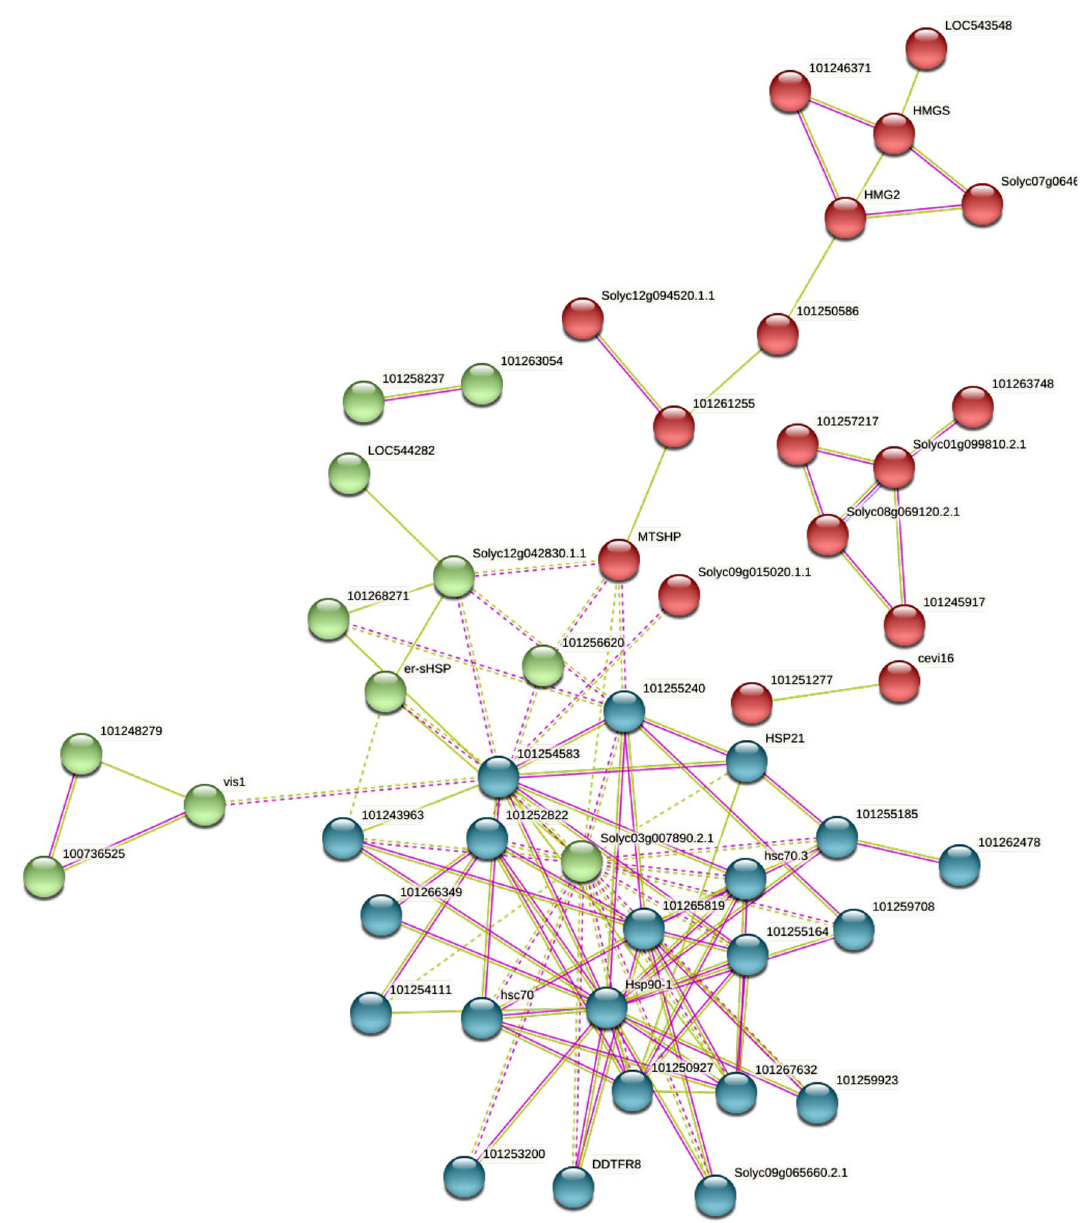
Figure 5. Protein–protein interaction network analysis of DEGs between transgenic 4–3 and wild type at flowering stage. The STRING database (http:// string- db. org/) was used to analyze the protein–protein interaction network based on the proteins corresponding to all